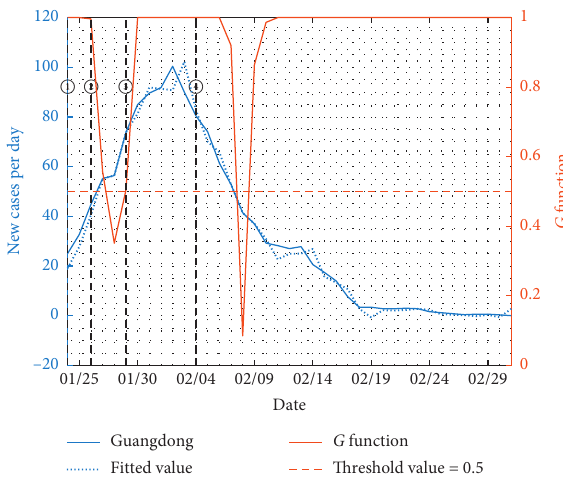
Figure 1: The fitting result of Guangdong Province, China. The left axis shows the daily confirmed cases for the real data after smoothness (blue solid line) and its fitted values by the STAR model (blue dashed line). The right axis shows the value of nonlinear functions G changing with time (orange solid line) and the reference line with threshold 0.5 (orange dashed line). The vertical dotted line indicates the sequential released policies: ① close entertainment and gatherings, ② close other places, ③ isolate confirmed cases, and ④ suspend urban traffic.